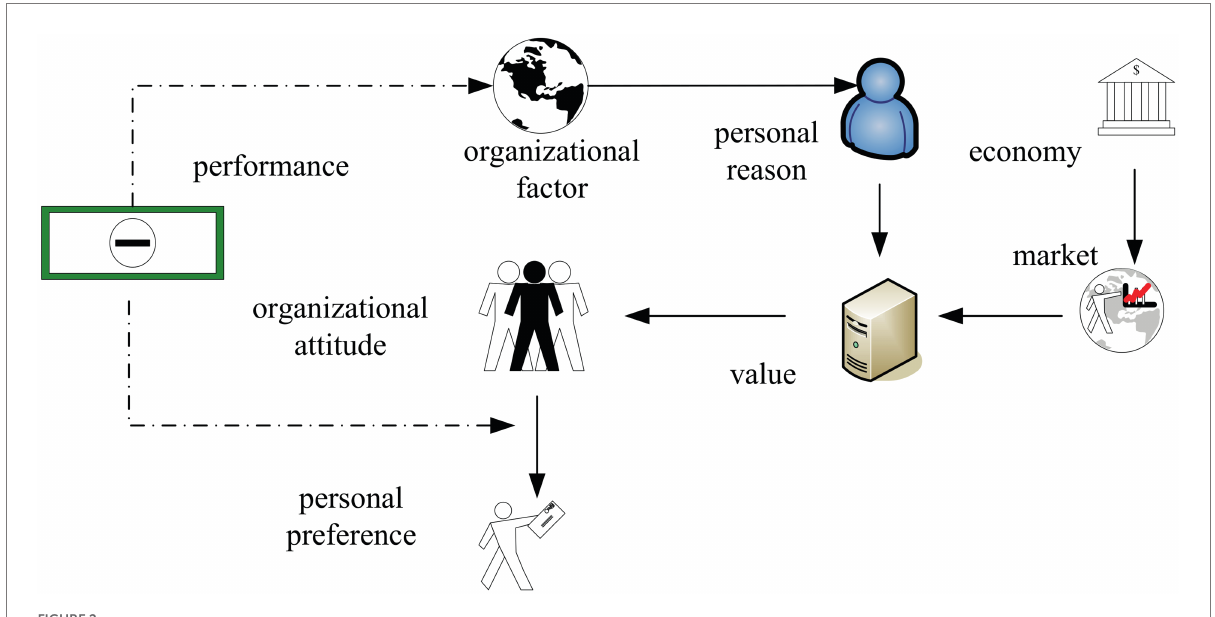
FIGURE 2 Personal willingness that arises in situations of occupational stress.